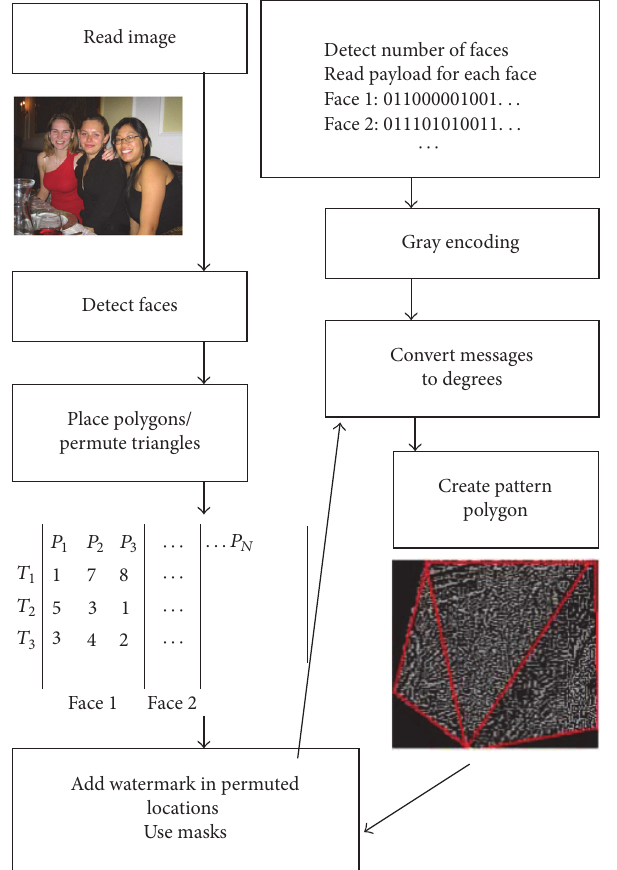
Figure 3: Overview of the watermarking process. T 1 – T 3 refer to the three triangles acquired using the Delaunay triangulation. 𝑃 1 – 𝑃 𝑁 refer to the new polygons being sets of three scattered